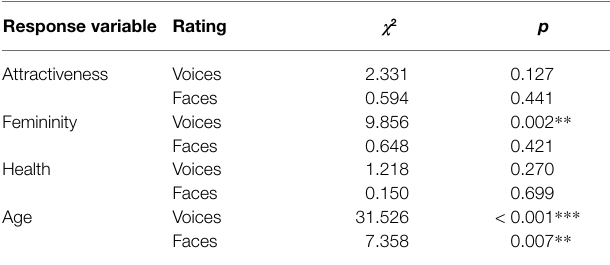
TABLE 1 | Model comparisons of the full linear models with the effect (voice pitch) in question against the null linear models without the effect in question. Response variable